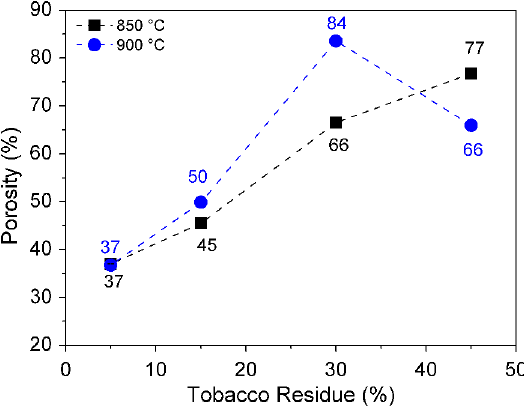
Figure 2. Porosity of glass foams produced containing 5, 15, 30 and 45% (mass) of T and fired at 850 and 900